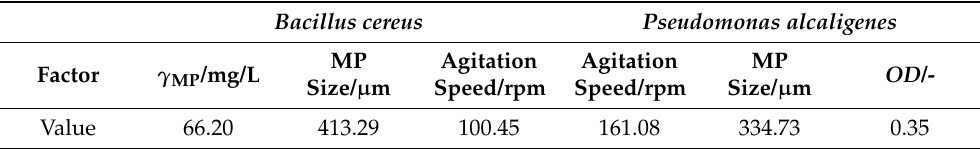
Table 6. Optimal conditions for MP-PS biodegradation by Bacillus cereus and Pseudomonas alcaligenes . Bacillus cereus Pseudomonas alcaligenes